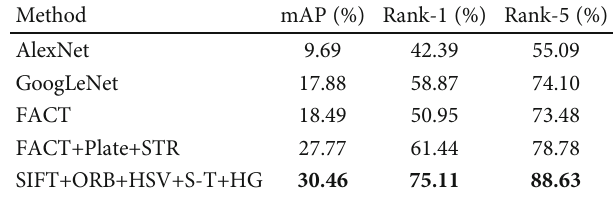
Table 2: ReID accuracy of Airport Expressway vehicles leaving Beijing.